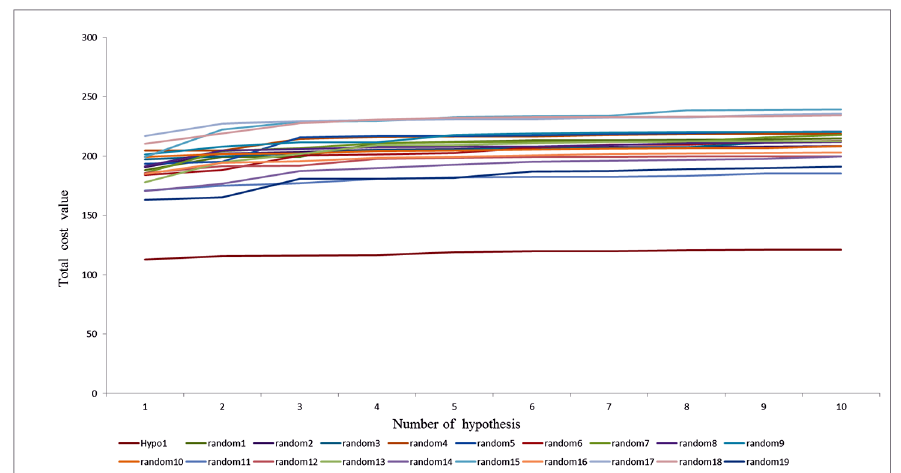
Fig 5. Comparison between the total cost of Hypo1 with the total costs of the 19 scrambled runs generated during the Fisher randomization run.